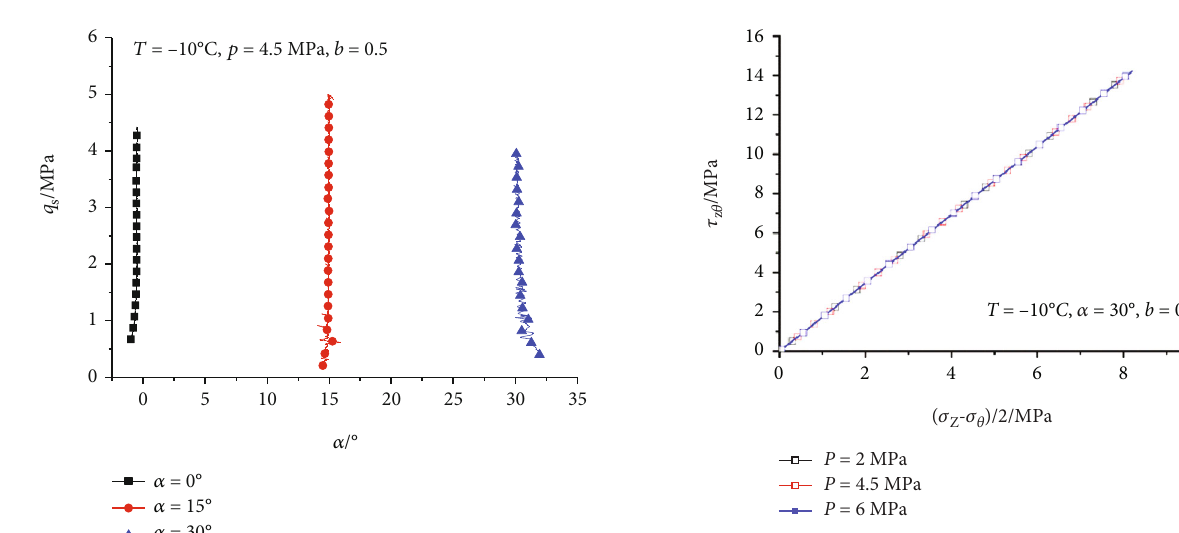
Figure 5: Relationships between directional angle of the major principal stress and shear stress under di ff erent principal stress directions.